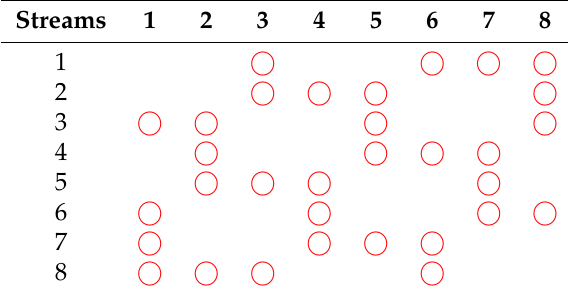
Table 1. All the pairs of incompatible